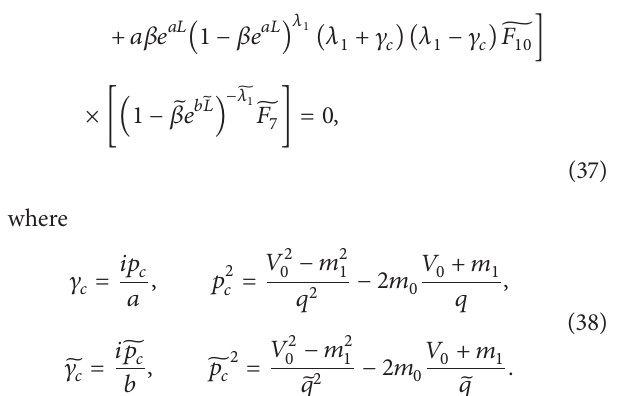
= 1 . (b) shows 𝐸 = 2 , 𝐿 = 0 , ̃𝐿 = 0 , 𝑎 = 1 , 𝑏 = 1 , 𝑝 = 1 , ̃𝑝 = 1 , 𝑞 = ̃𝑞 → 0 , and 𝑚 0